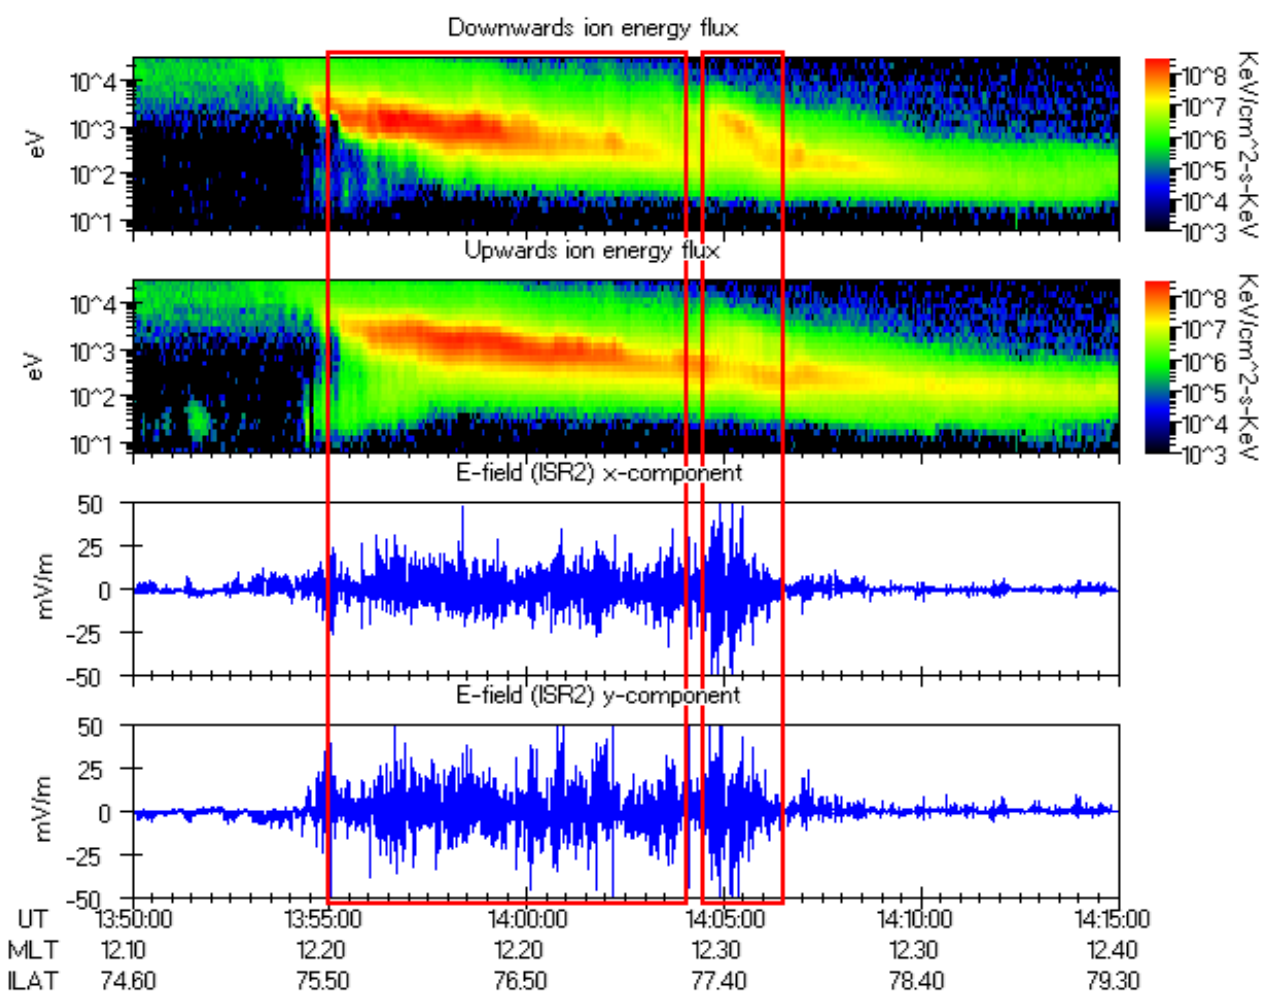
Fig. 8. The cusp pass of 10 September 2002. In the downward ion flux, two distinct injection events are clearly visible. The time intervals used when studying the correlation between BB-ELF power and ion flux are marked with red boxes. Note that these do not correspond exactly to the BB-ELF region defined in Fig. 1. The first box starts 30s later than the onset of BB-ELF as shown in that figure, and there is a 30s gap between the first and second box. This was done to avoid the transition